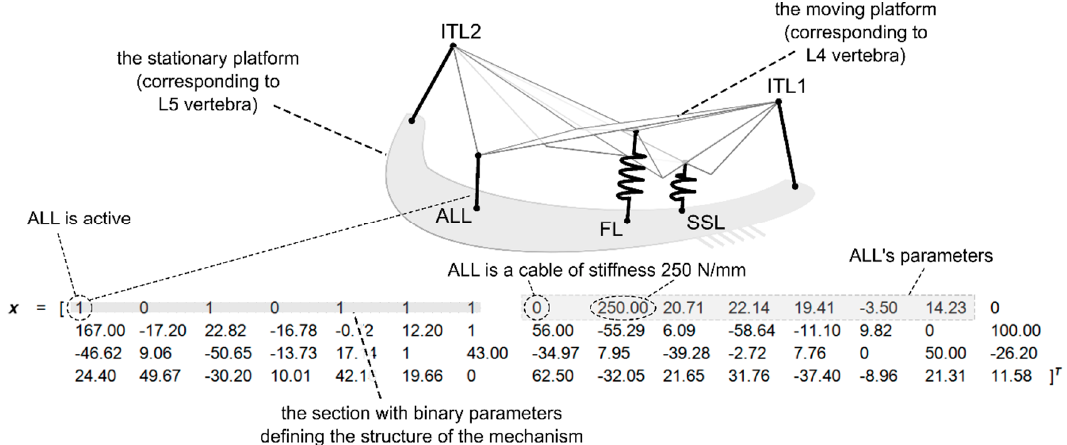
Figure 3. A sample structure with its corresponding decision variable vector in structured Genetic Algorithm (sGA). The image of the platform mechanism based on [30].